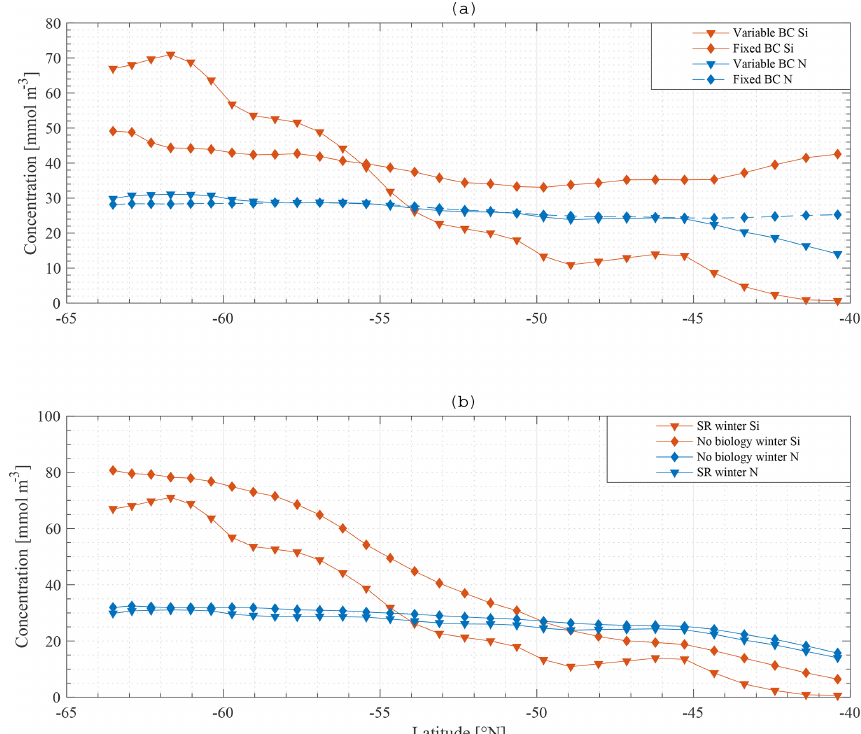
Figure 13. Model result: winter nitrate and silicate concentration in the mixed layer along the average meridional section – a comparison of the standard model run (SR) ( (cid:72) ) with a model run with constant boundary condition ( (cid:7) ) (a) and a model run without biology ( (cid:7) ) (b)